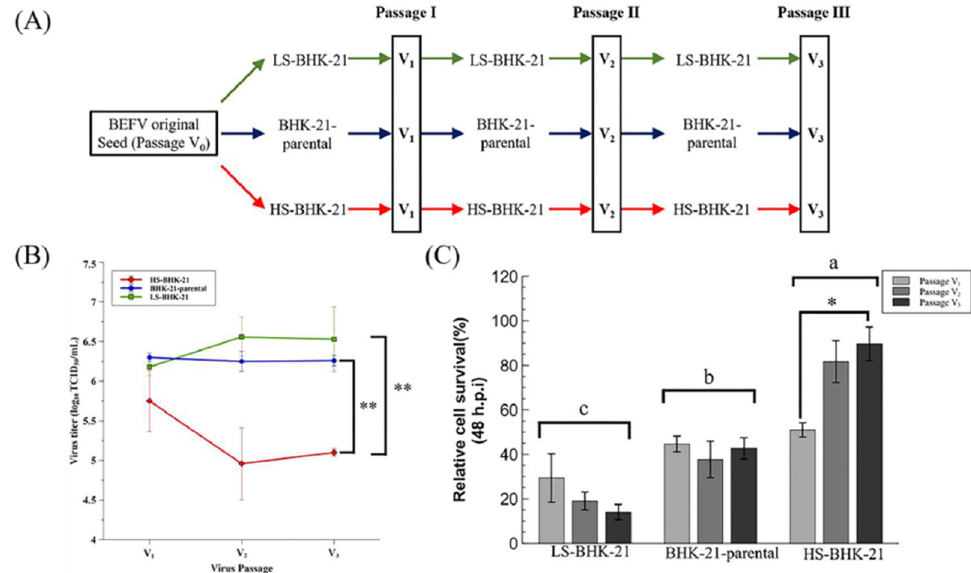
Figure 4. The virus production ability of the parental and subclonal cells in serial virus passages. ( A ) The three serial passages experiment design was showed. ( B ) The virus supernatant of the three continuous serial passages in three different cells population were harvested at 48 h.p.i., and determined by TCID 50 assay. ( C ) The relative cell survival percentage of the parental and subclonal cells were determined at 48 h.p.i. by directly trypsinized cell counting, and the percentage was compared to the mock infection, respectively. Three independent repeats were performed, and were analyzed by one-way ANOVA. Means with different letters are significantly different (Tukey’s HSD, p < 0.05). * p < 0.05, ** p < 0.01 compared to indicated group.